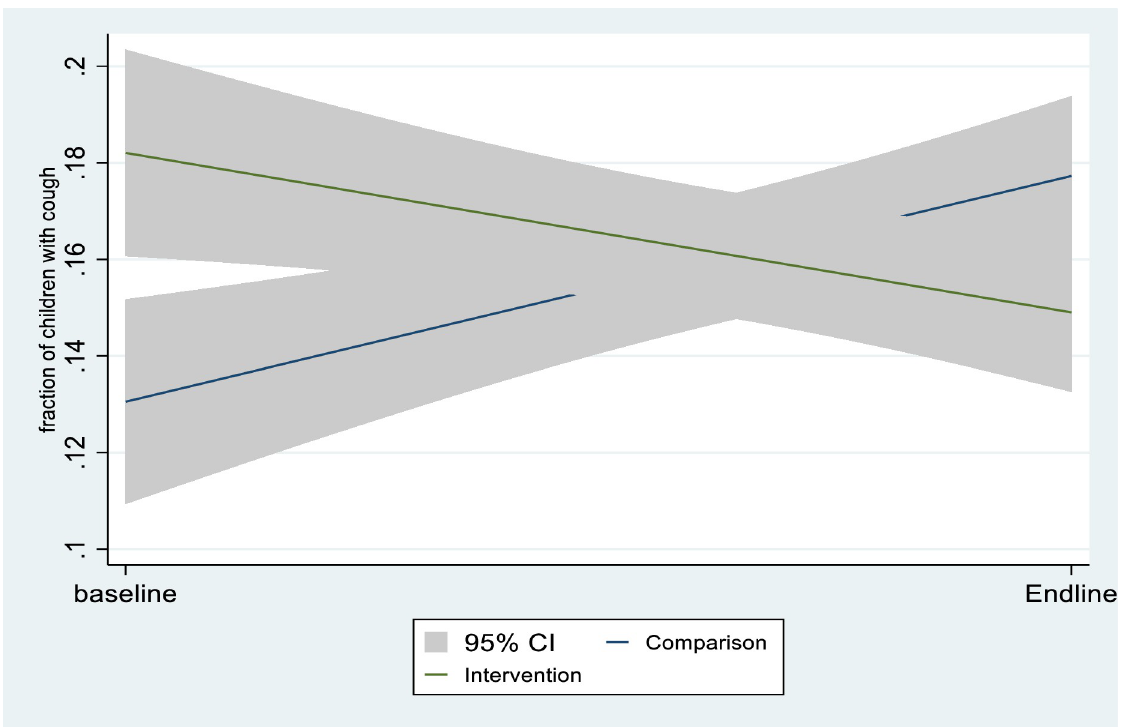
Fig 3. The effect of GEHIP on the incidence of childhood cough, according to maternal